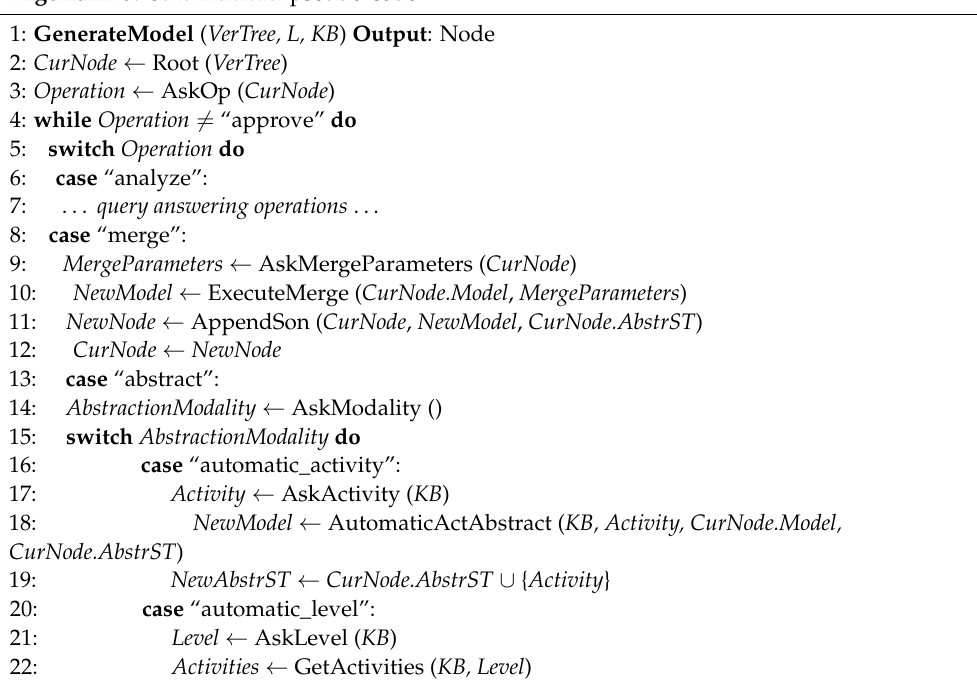
Algorithm 5: GenerateModel